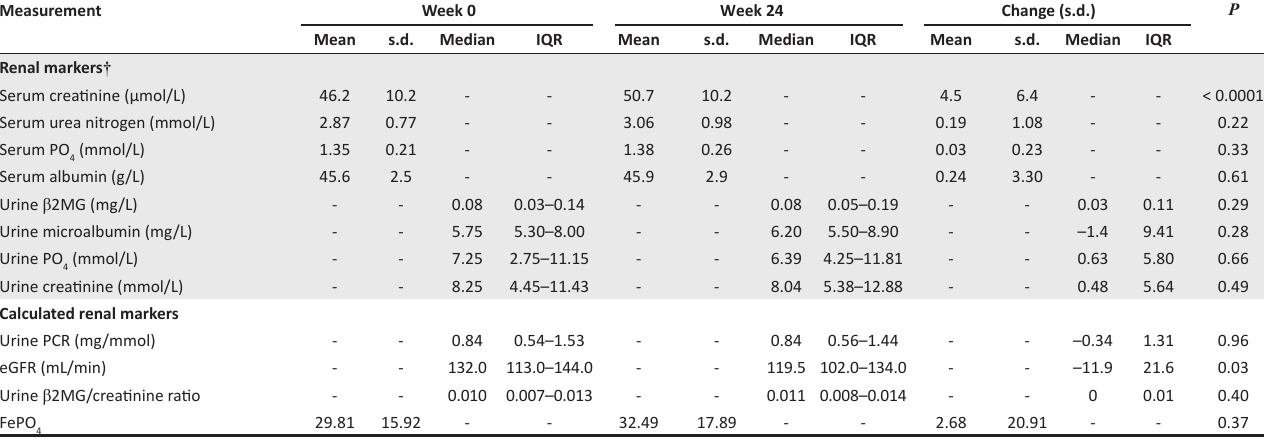
TABLE 4: Renal parameters at Week 0 and Week 24. Measurement Week 0 Week 24 C hange (s.d.)